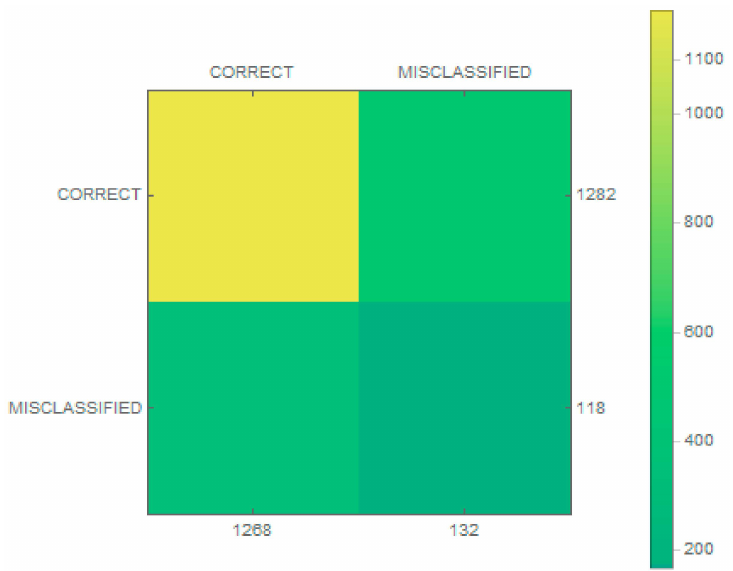
Figure 5. The confusion matrix of the classification